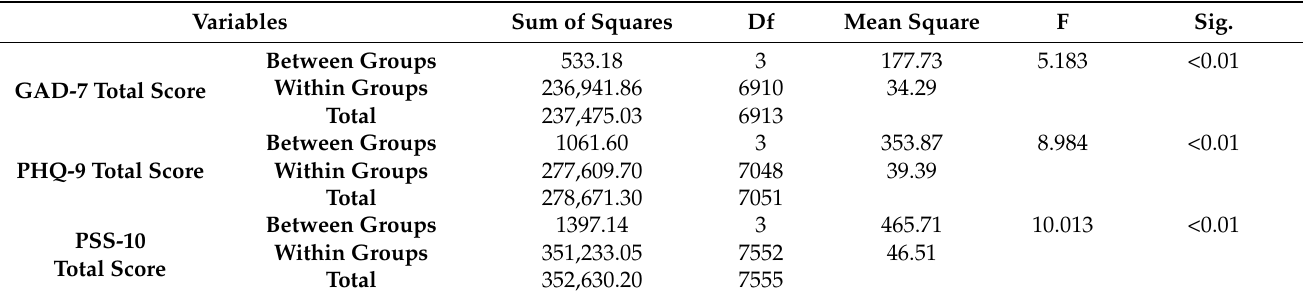
Table 4 represents the results of One-Way ANOVA comparing sums of squares between and within ethic groups for the PSS-10, PHQ-9, and GAD-7 scales. Table 4. ANOVA comparing sums of squares between and within ethnic groups.